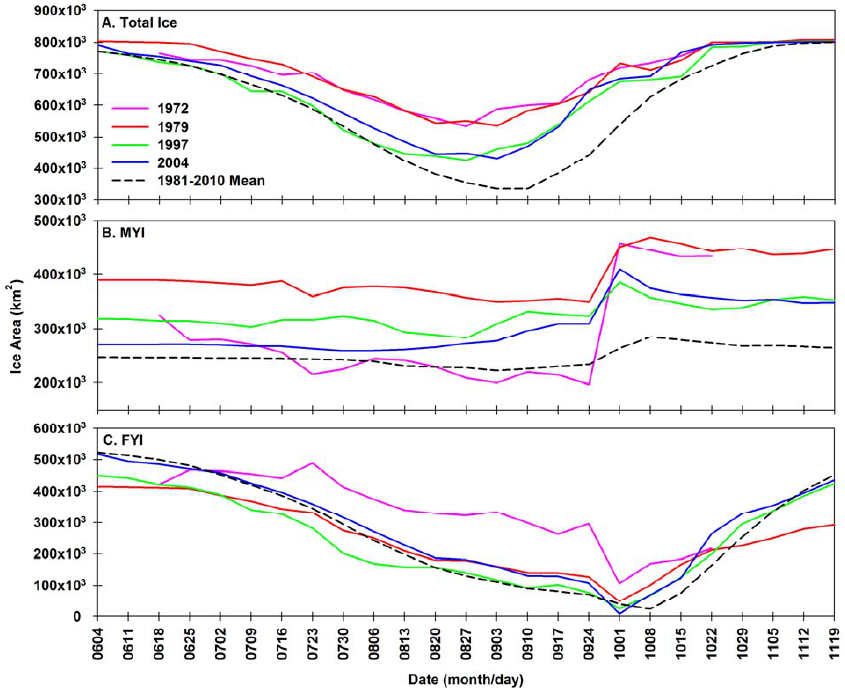
Figure 6. Weekly time series of total ice (A), multi-year (MYI) (B) and first year ice (FYI) (C) area (km 2 ) for 1972, 1979, 1997 and 2004 in the Canadian Arctic Archipelago. Fig. 6. Weekly time series of total ice (A) , multi-year (MYI) (B) and first-year ice (FYI) (C) areas (km 2 ) for 1972, 1979, 1997 and 2004 in the Canadian Arctic